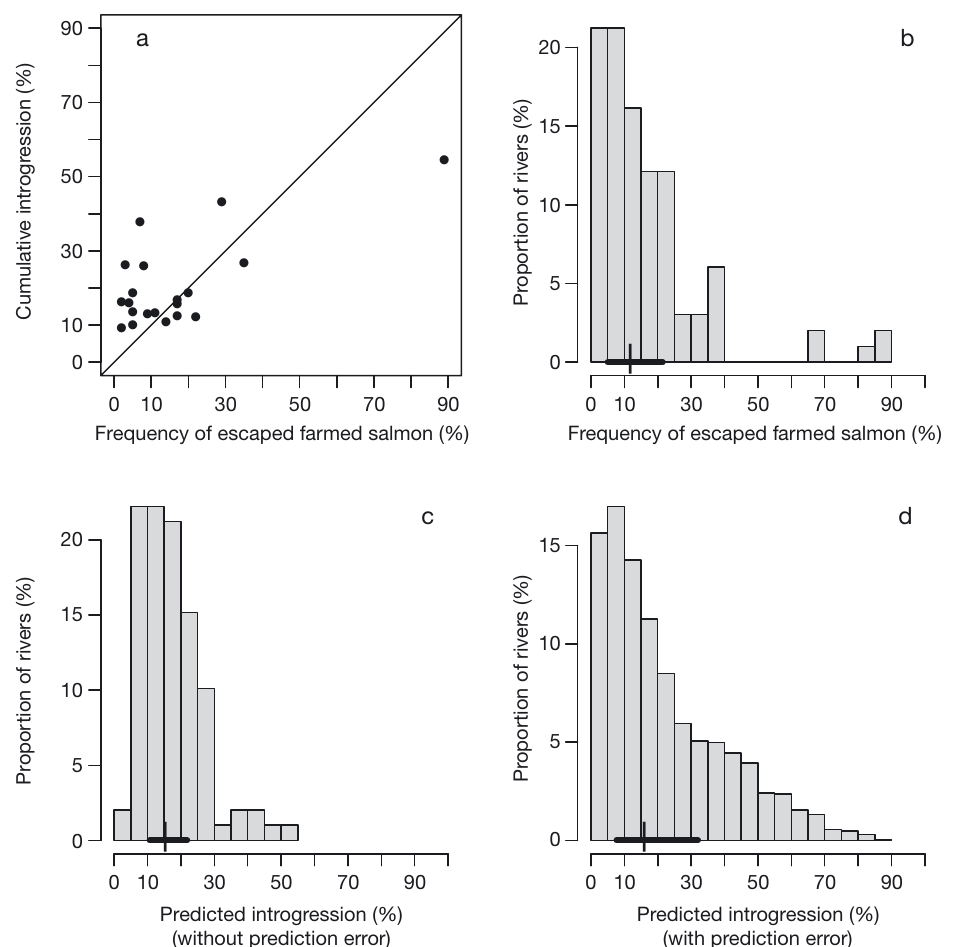
Fig. 1. (a) Relationship between the relative frequency of farmed Atlantic salmon Salmo salar (Diserud et al. 2012) and per- centage of introgression measured with genetic methods in 20 Norwegian salmon rivers by Glover et al. (2013). (b) Relative frequency of farmed salmon for 99 Norwegian salmon rivers (expressed as proportion of rivers affected) (Diserud et al. 2012). (c) Predicted percentage of introgression based on average annual catch weight and the relative frequency of farmed salmon for 99 Norwegian salmon rivers. (d) As (c), but including prediction error. In (b)−(d), the thick horizontal bar gives interquartile range and the short vertical bar the median of